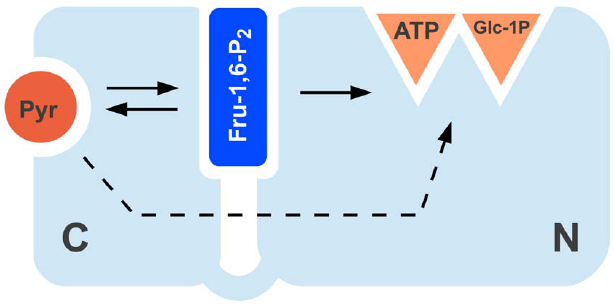
Figure 6. Proposed dual allosteric model for E.coli ADP-Glc PPase. The two main domains of the enzyme are illustrated by C and N. Catalysis occurs in the N-domain where the active site for ATP and Glc-1P is located. Full and dashed arrows indicate a strong and weak positive interaction, respectively.